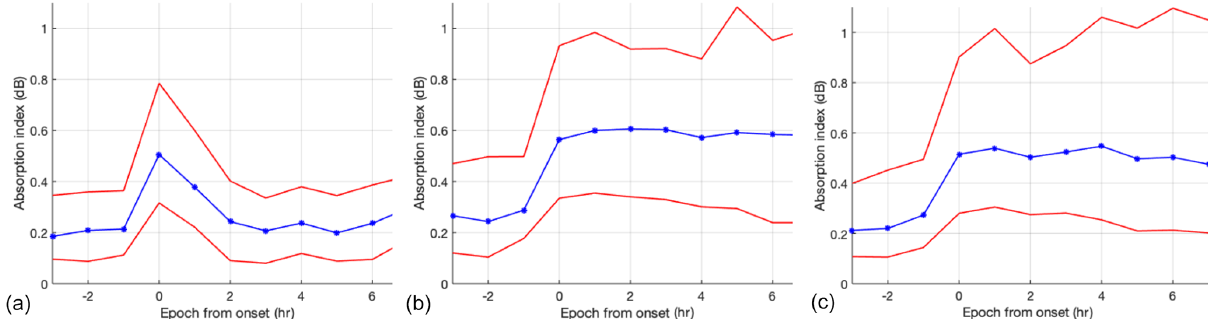
Figure 4. A superposed epoch view of the isolated (a) , compound (b) , and multi-night (c) substorm events from − 3 to + 7h from the onset of the first expansion phase. For multi-night events, the onset is the start of the first expansion phase of each night. The median curves are blue and the 25% and 75% percentile curves are red.